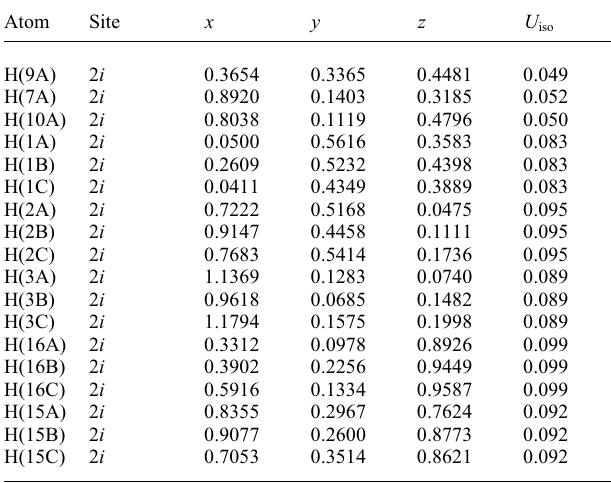
C8–C10 single bond [1.458(3)Å], forming the C12–C10–C8 bond angle of 136.7(2)°. The crystal structure is stabilized by weak intermolecular C–H ’’’ O hydrogen bonds. Table 2. Atomic coordinates and displacement parameters (in Å 2 )